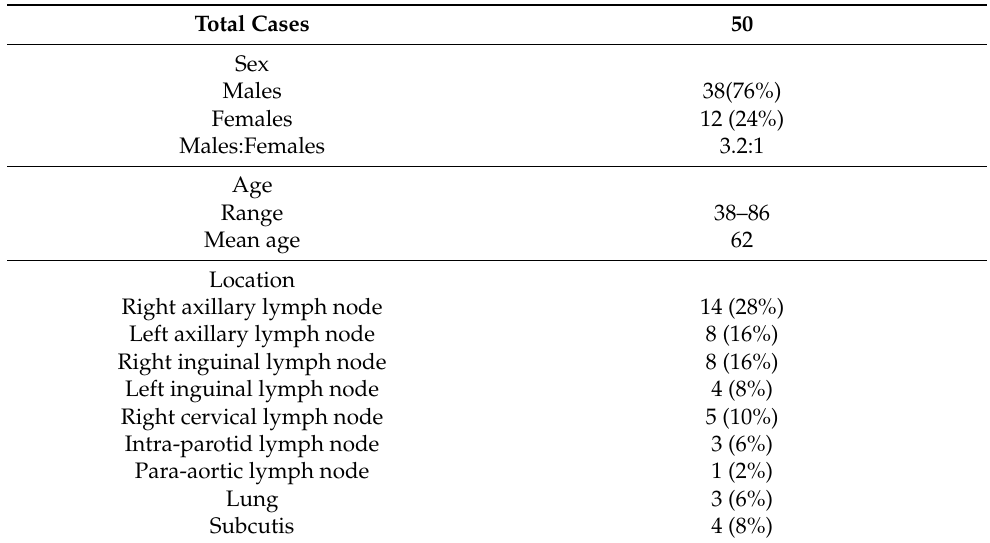
Table 1. Clinical findings.